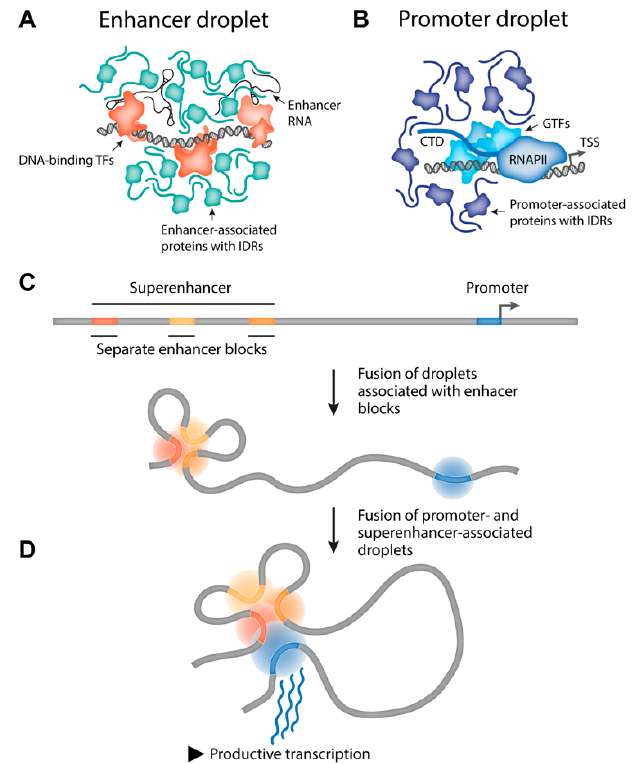
Figure 3. Enhancer-promoter contacts may be formed by the LLPS. Multivalent interactions between transcriptional machinery components drive the formation of liquid droplets at enhancer blocks within the superenhancer ( A ) and at the controlled promoter ( B ). Distinct droplets at the superenhancer may be fused due to being located in close proximity to each other, giving rise to a “superdroplet” encompassing the entire superenhancer region ( C ). 1D- or 3D-scanning of the nuclear space results in superpositioning of the superenhancer and promoter that leads to fusion of their liquid droplets ( D ). This structure, characterized by high local concentration of transcriptional activators, facilitates the productive transcription initiation from the